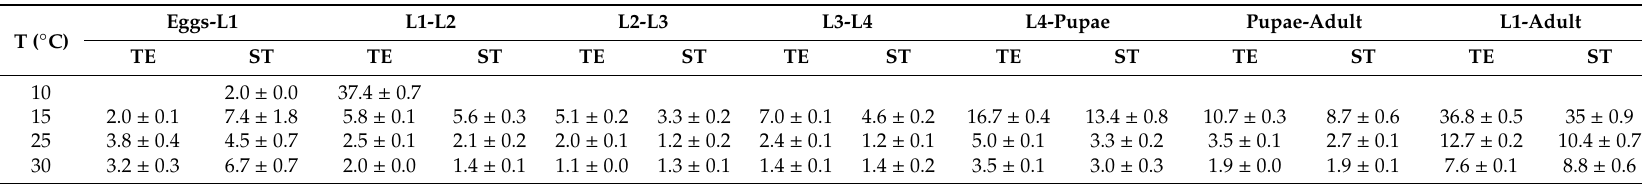
Table 2. Temperate Ae. albopictus developmental time. Length of time between immersion of eggs in water and hatching response and duration of development (mean and standard error in days) of each stage of temperate (TE) and subtropical (ST) Ae. albopictus maintained at four constant temperatures: 10, 15, 25, and 30 ◦